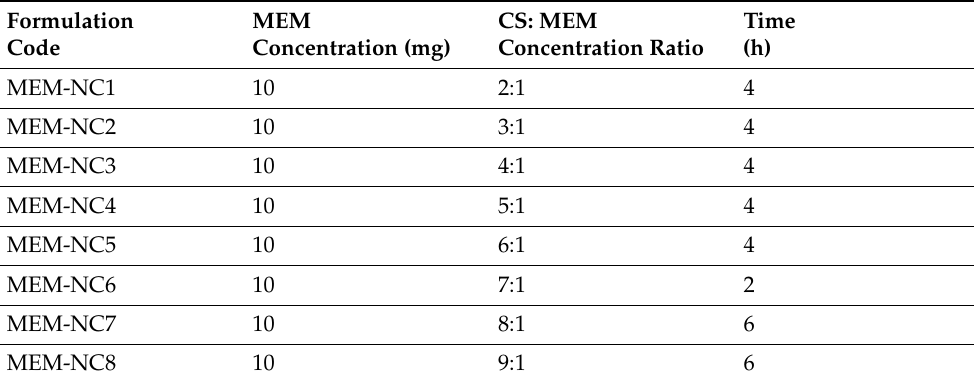
Table 1. Various formulation concentration and condition of MEM-NCs. Formulation